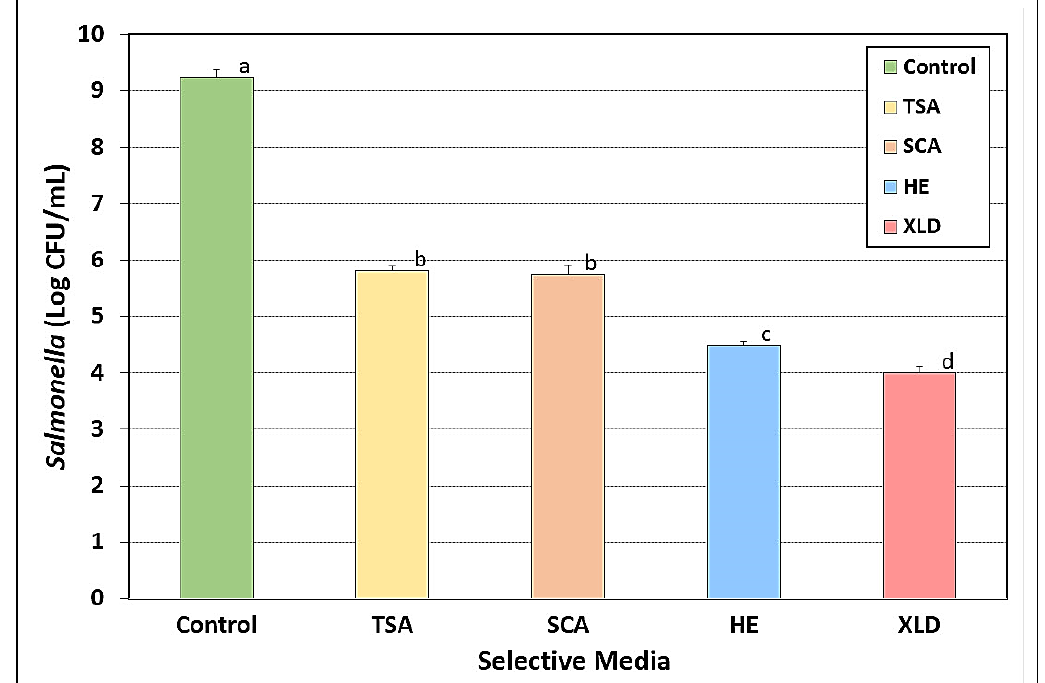
Figure 9. Thermal-stress response of five-serovar mixture of Salmonella heated at 62.8 °C (145 °F) for (5 ug / mL), novobiocin (50 ug / mL), and clindamycin (5 ug / mL). Cultures in the mixture 75 sec. Treated samples were then plated on TSA, SCA, HE, and XLD; all contained spectinomycin (5 ug/mL), novobiocin (50 ug/mL), and clindamycin (5 ug/mL). Cultures in the mixture included S.